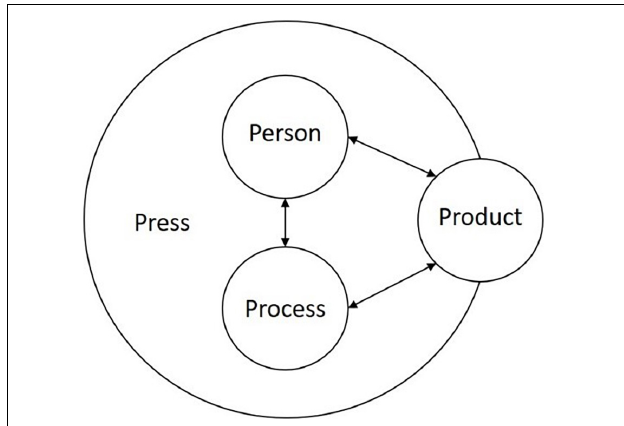
FIGURE 4 | Theoretical framework of a Psychosocially Safe Engineering Environment that Facilitates Creative Problem Solving as envisaged through the Four Ps. Adapted from Rhodes (1961) and Cropley